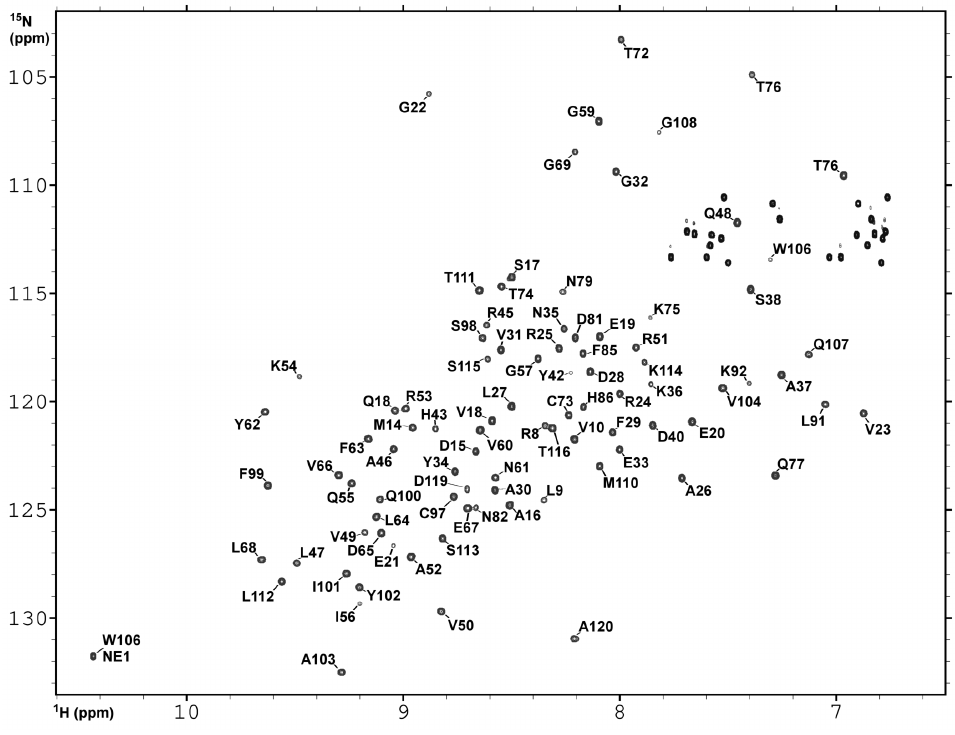
Figure 3. The 1 H- 15 N HSQC spectrum acquired for h CC V57G in the presence of DMPC-d54 on Agilent DDR2 NMR spectrometer at 298 K. The assignments of 1 H and 15 N backbone resonances are presented as one-letter code and sequence